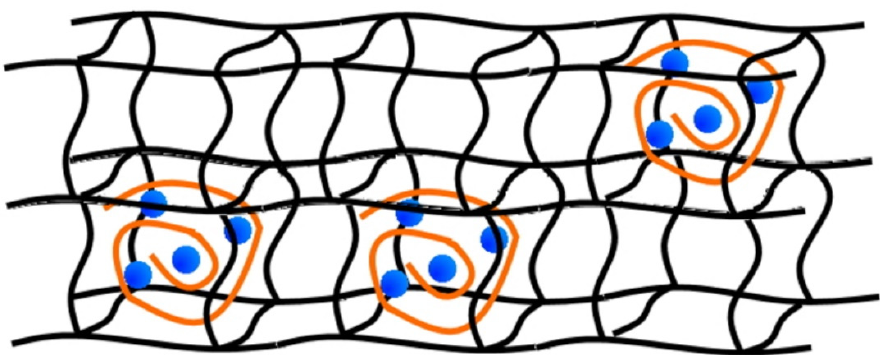
Scheme 1. Schematic representation of the structural arrangement of AgNCs-PMAA nanostructures tures trapped in the PEGDA 700 network. trapped in the PEGDA 700